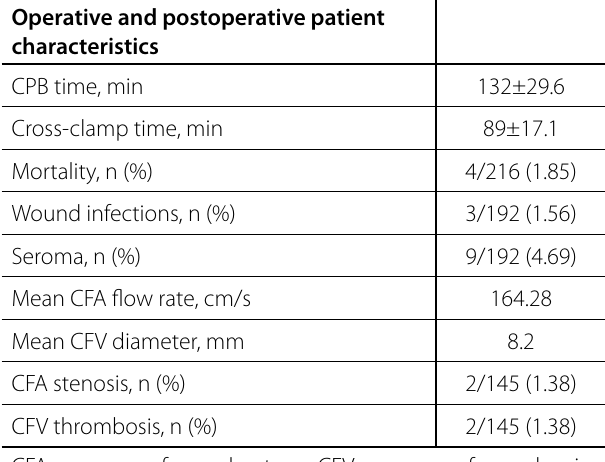
Table 3. Surgical parameters and postoperative mortality and peripheral vascular parameters and complications in patients who underwent robotic cardiac surgery with femoral cannulation using the U-suture